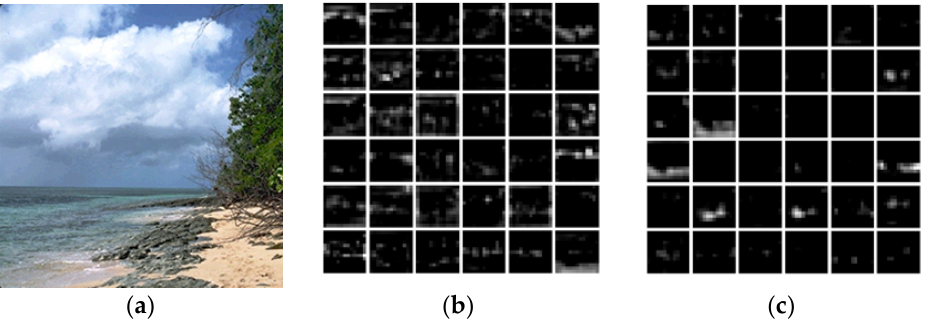
Figure 2. Visualization of feature maps in the network. ( a ) original image; ( b ) conv3; ( c ) conv5.